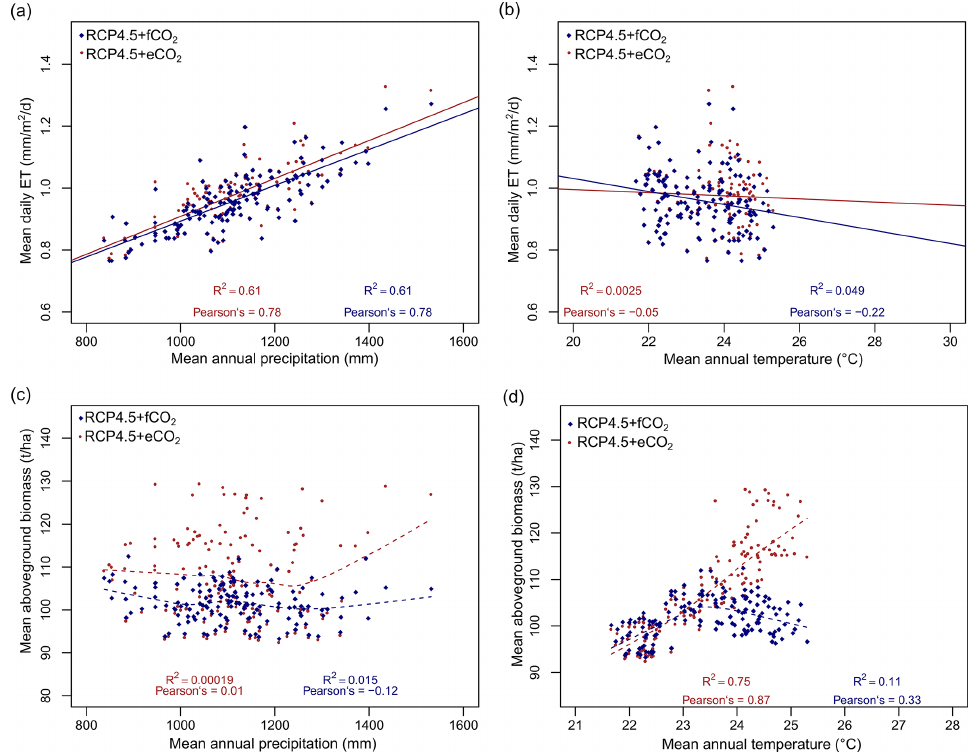
Figure 6. Relationship between (a) evapotranspiration (ET) and mean annual precipitation (MAP), (b) ET and mean annual temperature (MAT), (c) mean aboveground biomass and MAP, and (d) mean aboveground biomass and MAT under RCP4.5. The lines (both solid and dotted) in all figures represent the best-fit regression line. Data points represent spatially averaged ET (a, b) and biomass (c, d) over all of South Asia for each year from 1950 to 2099. See Fig. S8 for results under